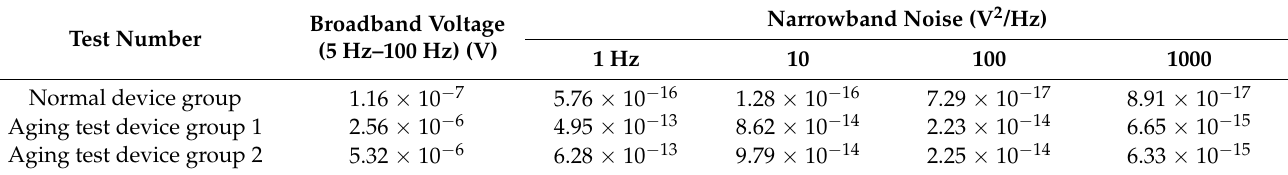
Table 1. Low-frequency noise data of